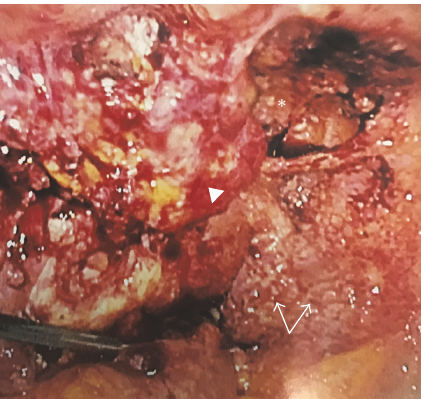
Figure 1: Intraoperative findings of disseminated pelvic tuberculo- sis: on diagnostic laparoscopy, diffuse disease presumed to represent advanced-stage ovarian cancer which included an obliterated poste- rior cul-de-sac ( ∗ ), numerous granulomas (arrows), and distorted pelvic viscera where only uterine body was identified (arrow